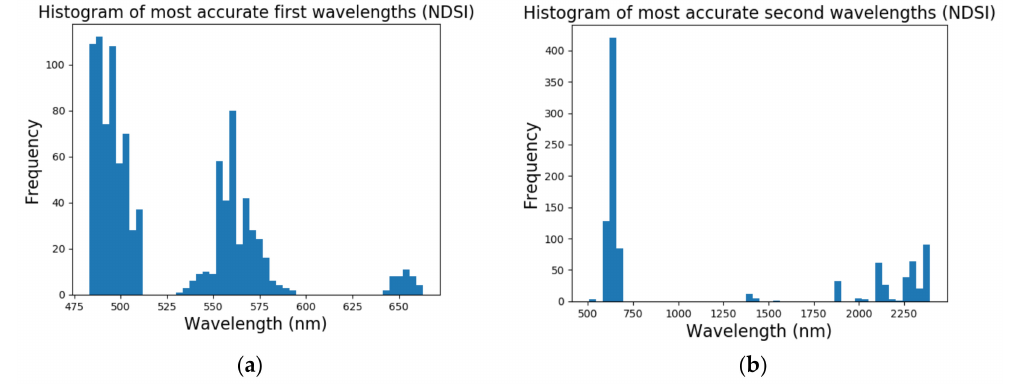
Figure 12. Frequency based on wavelengths for normalized di ff erence snap-bean growth index (NDSI) via SVM classifier, where first wavelength = w1 and second wavelength = w2 in ( w1 − w2 ) / ( w1 + w2 ) . Histogram of the most accurate first wavelengths represented in ( a ), while ( b ) shows the most accurate second